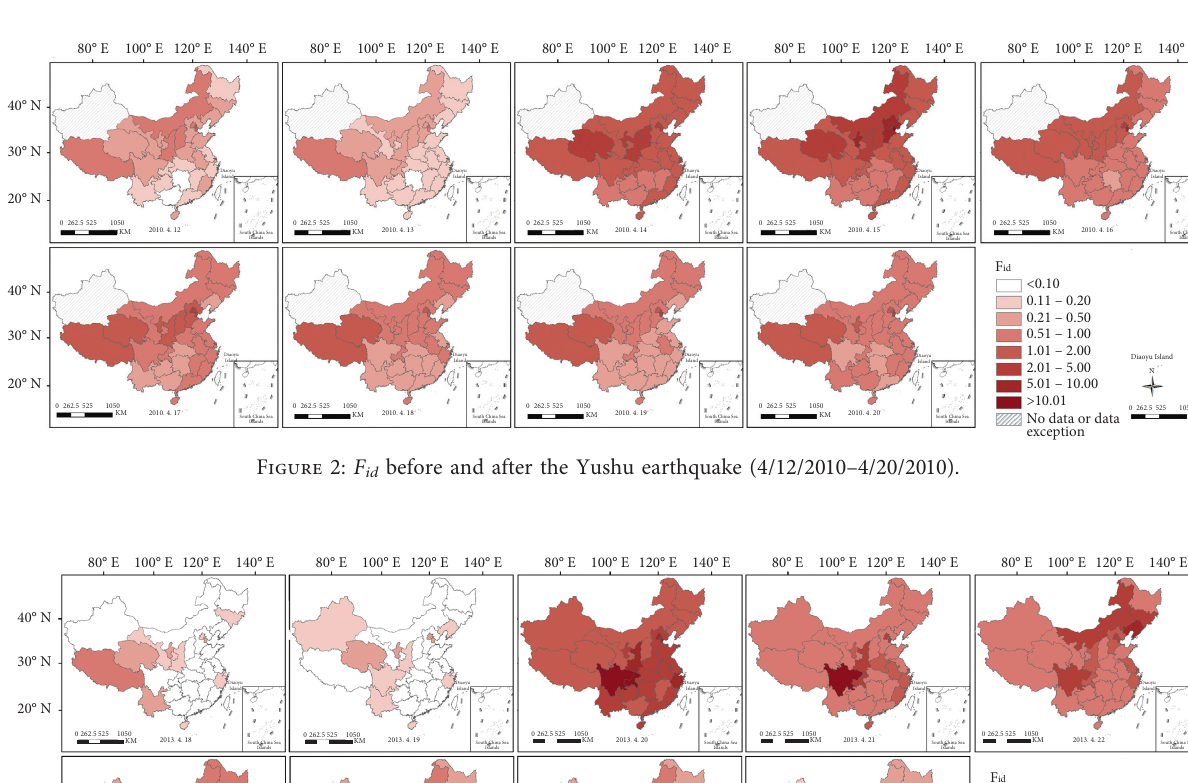
Figure 1: Time series of F d before and after the Yushu earthquake, the Yaan earthquake, and the Ludian earthquake.